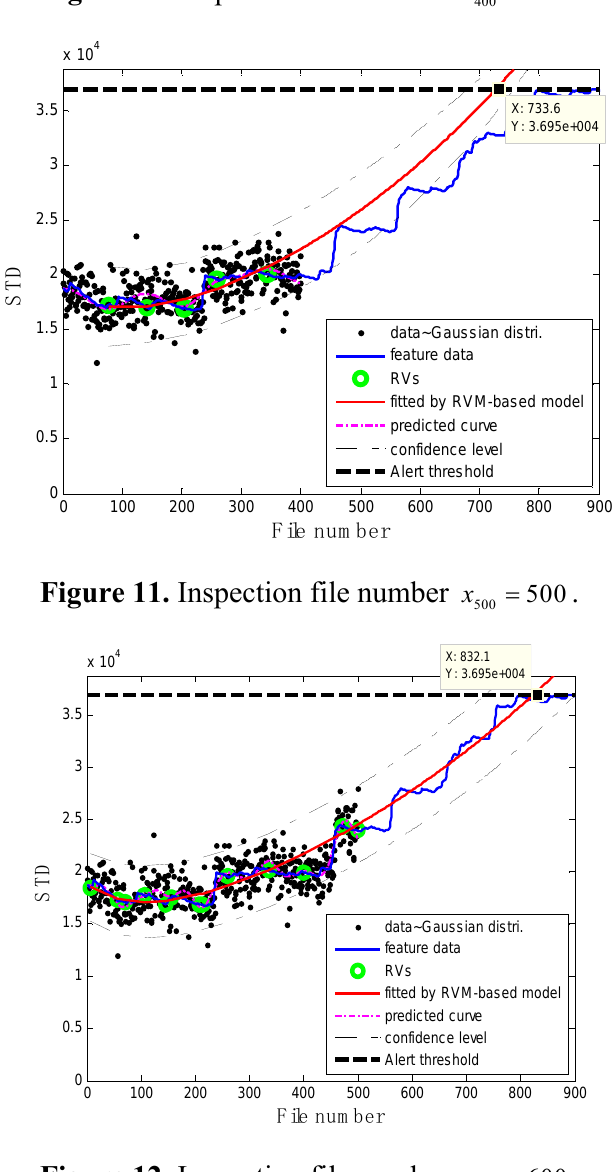
Figure 10. Inspection file number